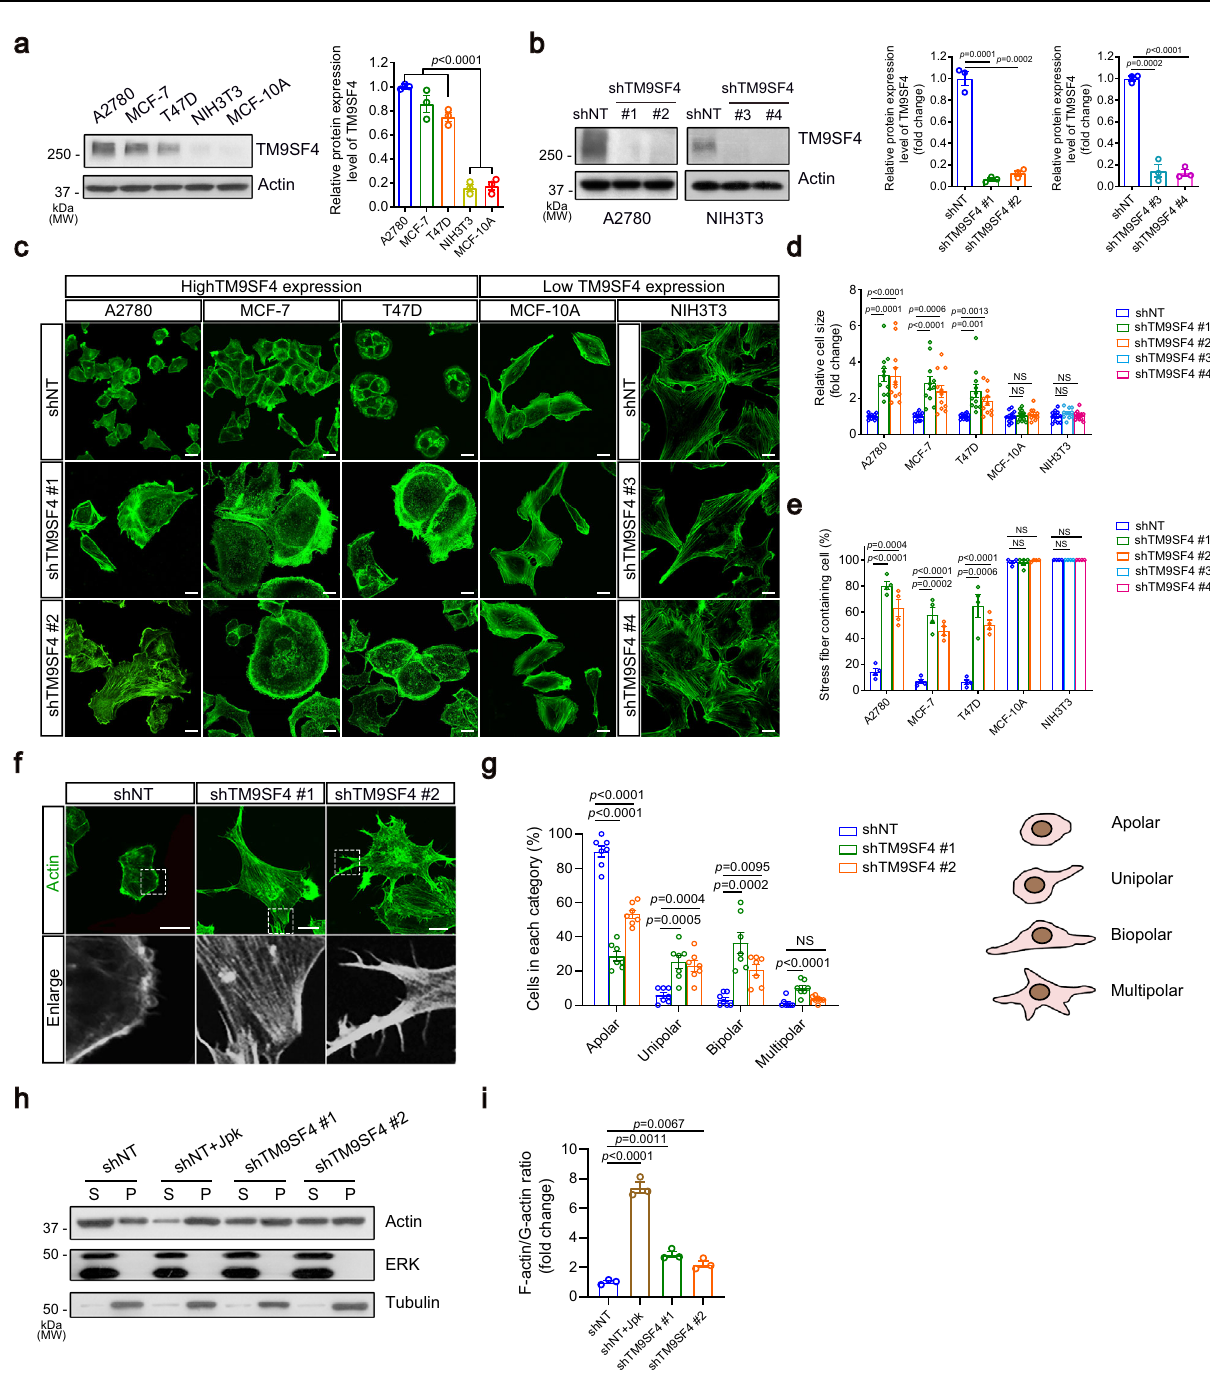
bar=10 μ m. f , g TM9SF4 knockdown increased the formation of actin spikes and multipolar morphology in A2780 cells. Shown are representative cell images after FITC-phalloidin staining ( f ) and summary data ( g ) ( n =7 biologically independent experiments).Scalebar=10 μ m. h , i TM9SF4knockdownincreasedtheF-actinasin pellet (P) whilereduced the G-actin as in supernatant (S) in A2780 cells. Shown are representative immunoblot images ( h ) and summary data ( i ). ERK, cytosolic mar- ker; β -tubulin, cytoskeleton marker ( n =3 biologically independent experiments). Data are presented as mean±SEM and two-tailed unpaired Student ’ s t -test was usedforstatisticalanalysis( a , b , d , e , g , i ).NS,nosigni fi cantdifference.Sourcedata are provided as a Source Data fi